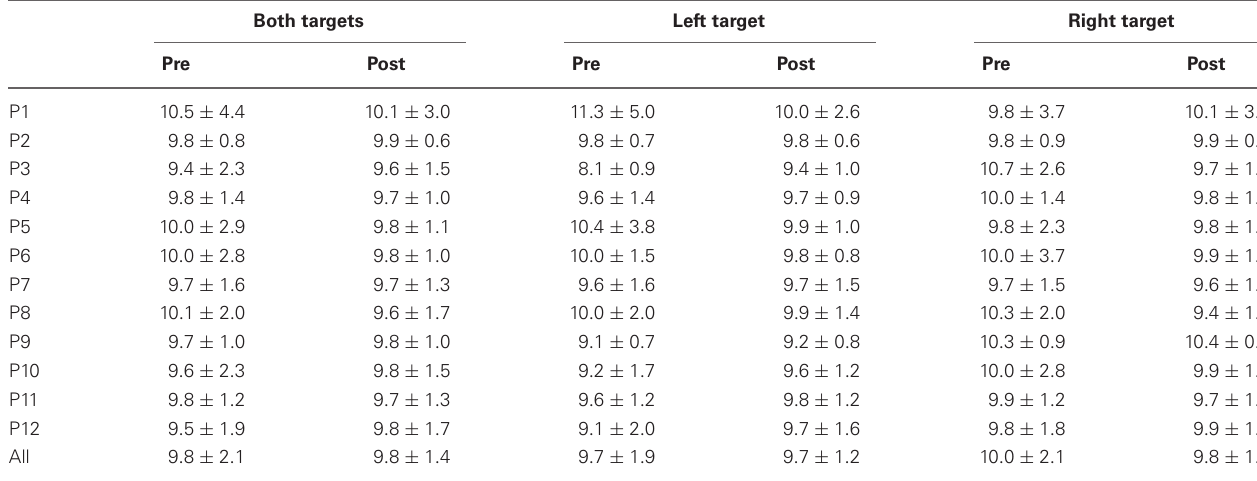
Table 3 | Mean ± Standard deviation of amplitude in degrees for both, left, and right targets in the two periods, for every participant and the group of participants (All). Both targets Left target Right target